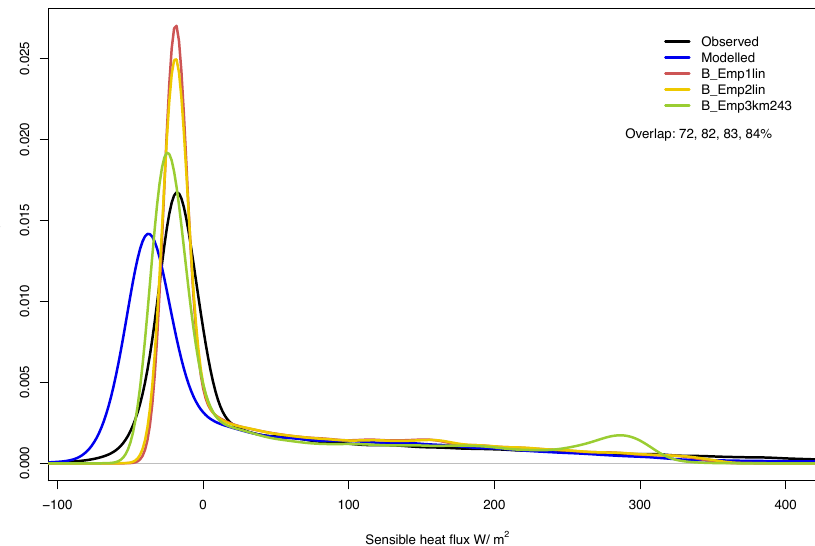
Fig. 3. Probability density functions (PDFs) of observed (black) and modelled (blue) sensible heat flux at a single flux tower site. Three additional PDFs representing a hierarchy of empirical models are also shown. The proportion of overlap of observed and modelled (or a benchmark PDF), expressed as a percentage, is used as the scalar metric for this analysis type. Metric values are listed in the same order as the